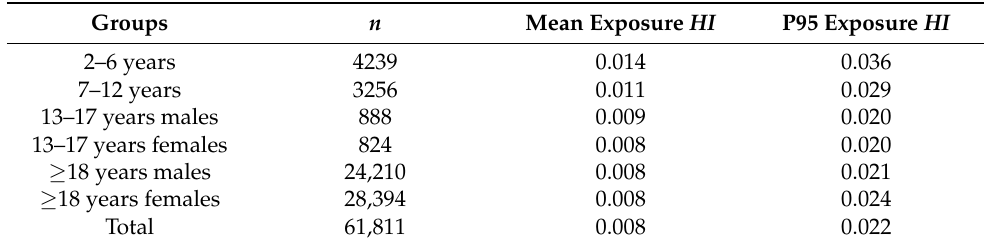
Table 4. The HI of the mean and P95 exposure of Ce, La, and Y in the general population and different sex–age groups of the Chinese